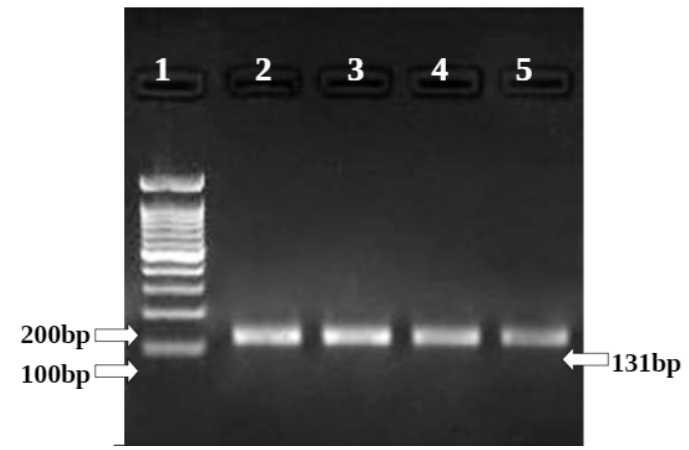
Figure 15. Gene regulation expression of Bcl2 gene in HepG2 cell line .